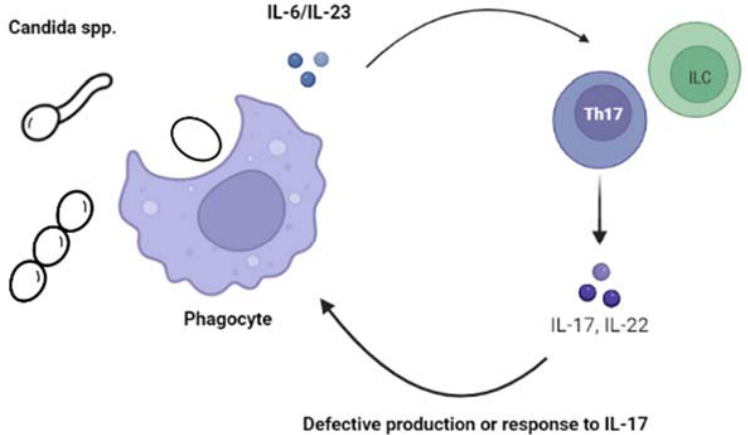
Figure 1. Alterations of the IL-17 immunity increases the susceptibility to chronic mucocutaneous candidiasis